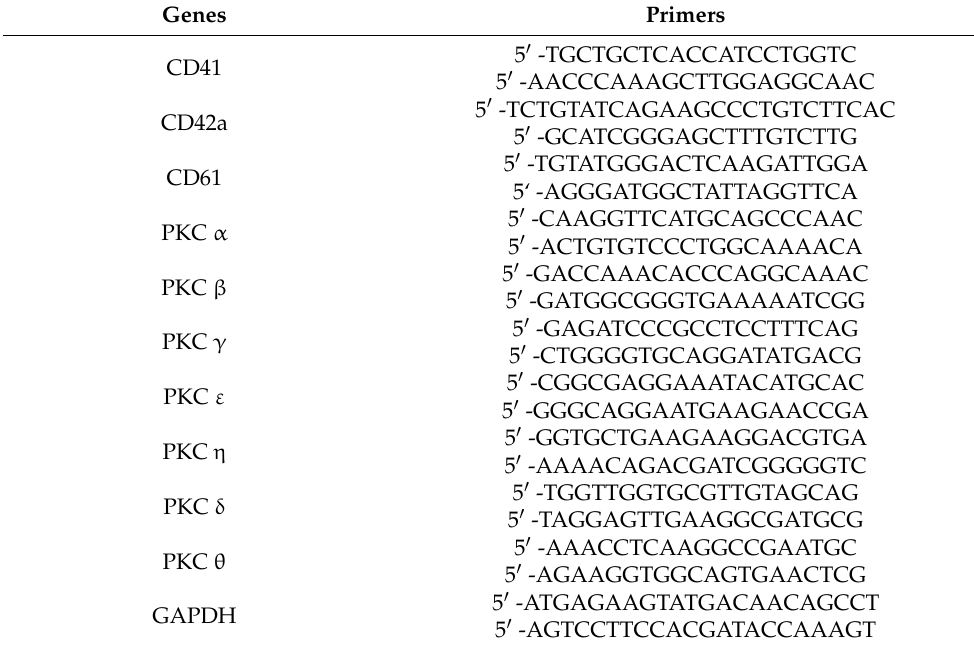
Table 1. The primer pairs used for quantitative real-time PCR.